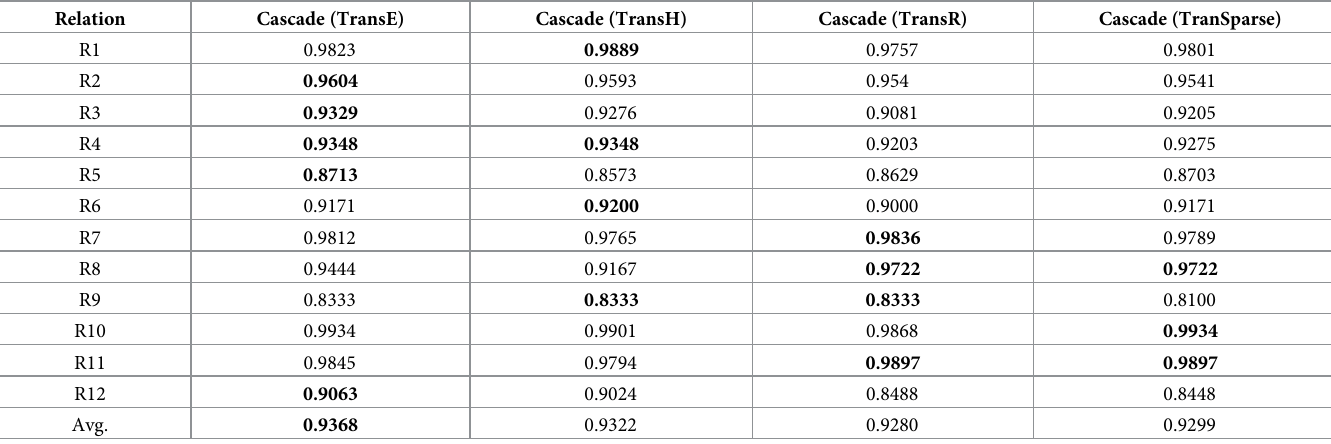
Table 4. Link Prediction based on settings of different knowledge embedding algorithms (accuracy).